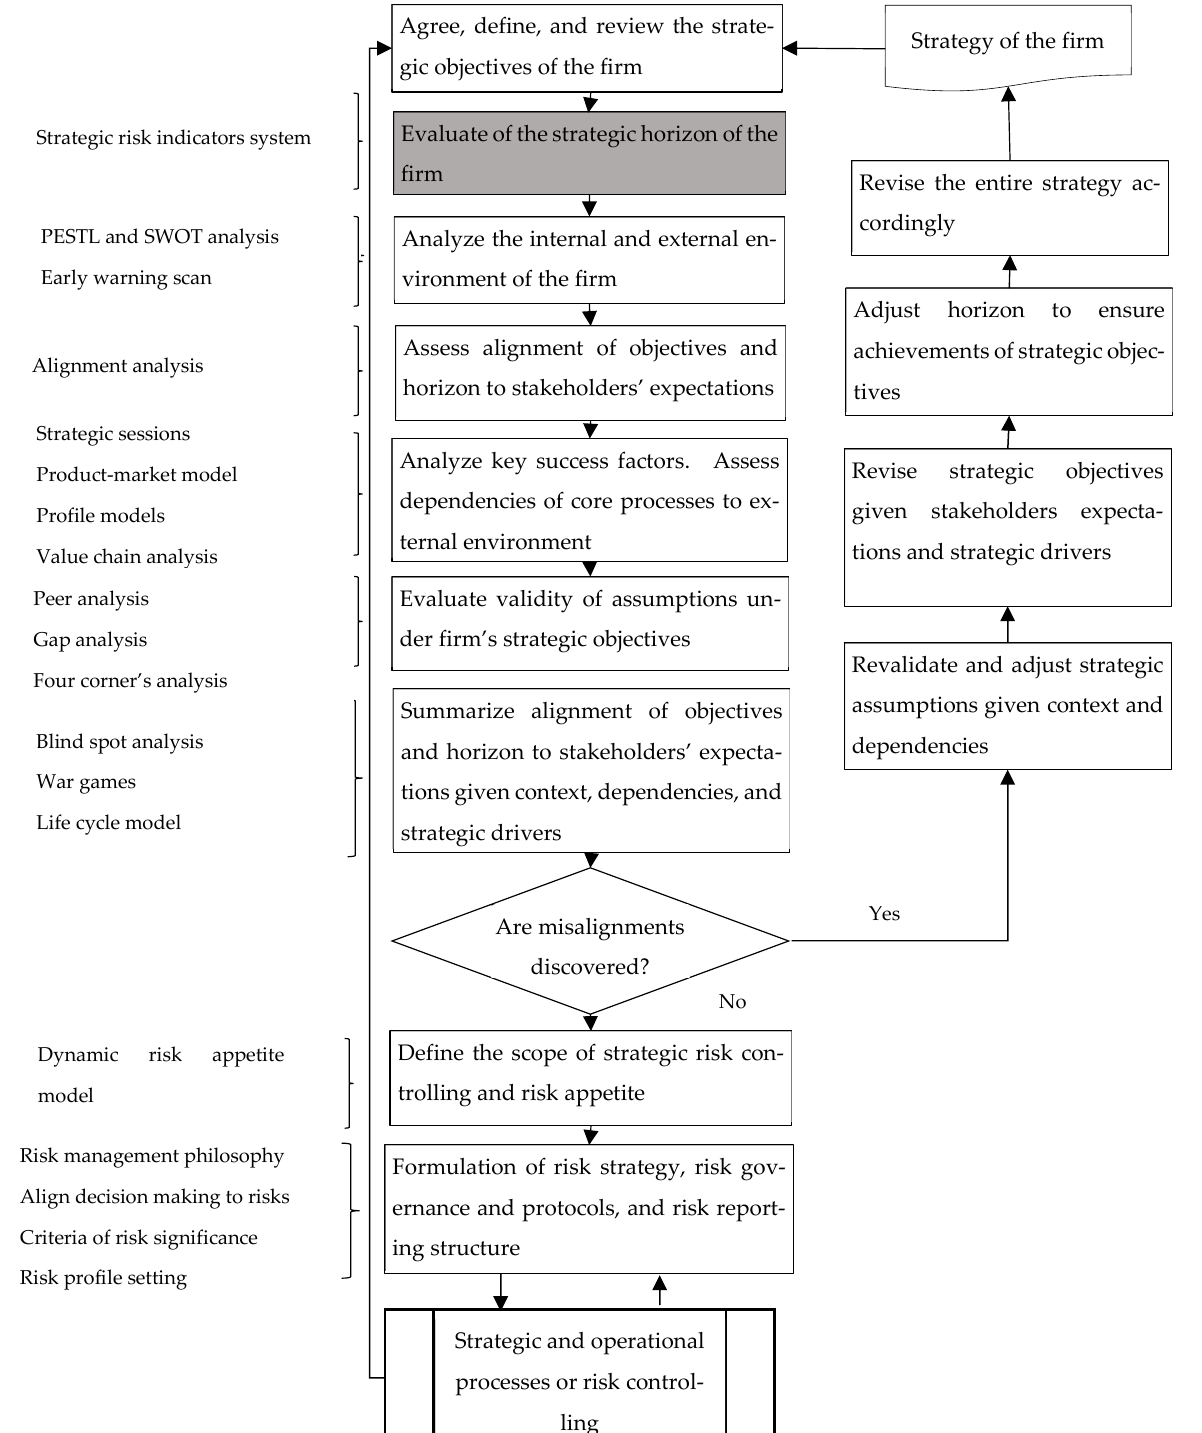
Figure 1. The mechanism of setting up the strategic management architecture. Source: developed by authors.